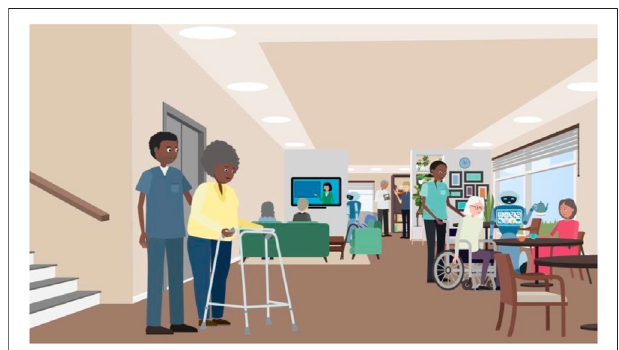
FIGURE 1 | Illustration used in VWT role-play interview showing the communal area of the supported living